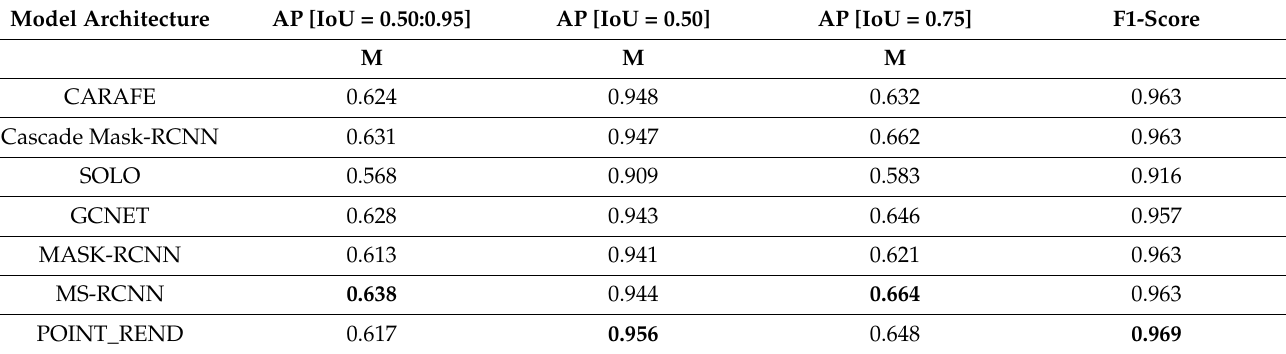
Table 4. Average precision results on G1020